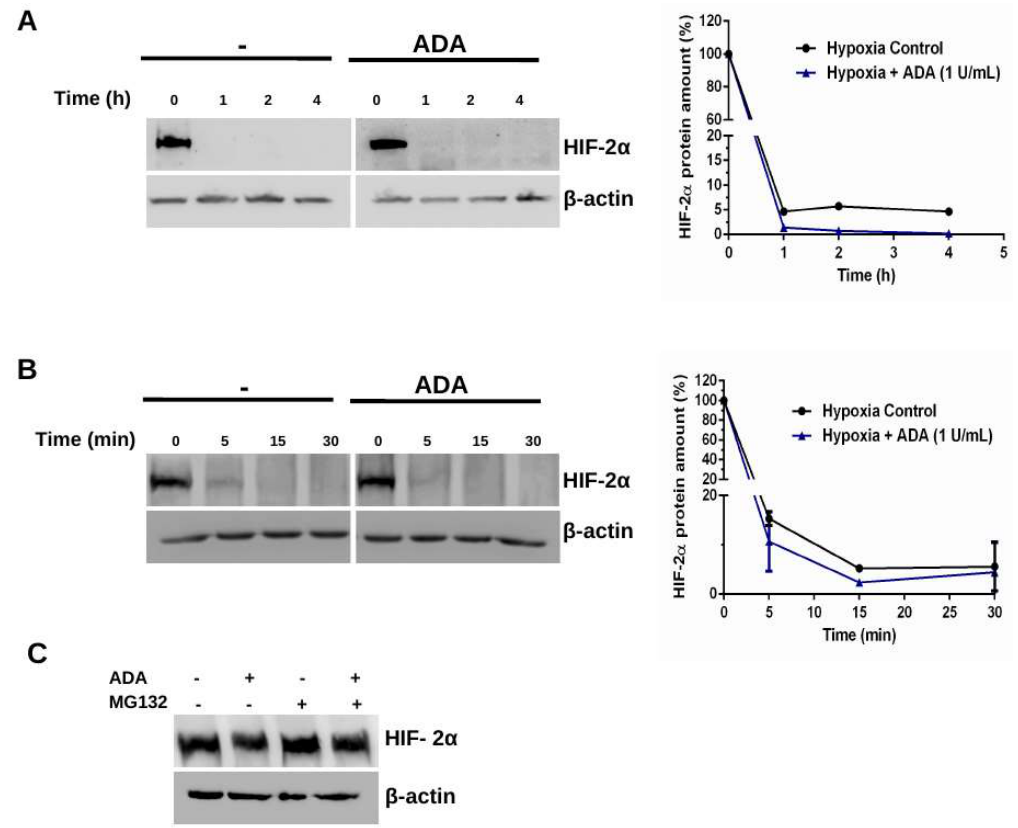
Figure 2. HIF-2α protein stability. ( A ) Hypoxic U87-GSCs were treated with 20 μg/mL CHX in absence or presence of 1 U/mL ADA for 0–4 h. Protein levels were analyzed by western blot and then plotted. ( B ) Same as in A , but ADA treatment was between 0–30 min. ( C ) Hypoxic U87-GSCs were treated with 10 μM MG132 and/or 1 U/mL ADA for 24 h and proteins were analyzed by western blot. n = 3.